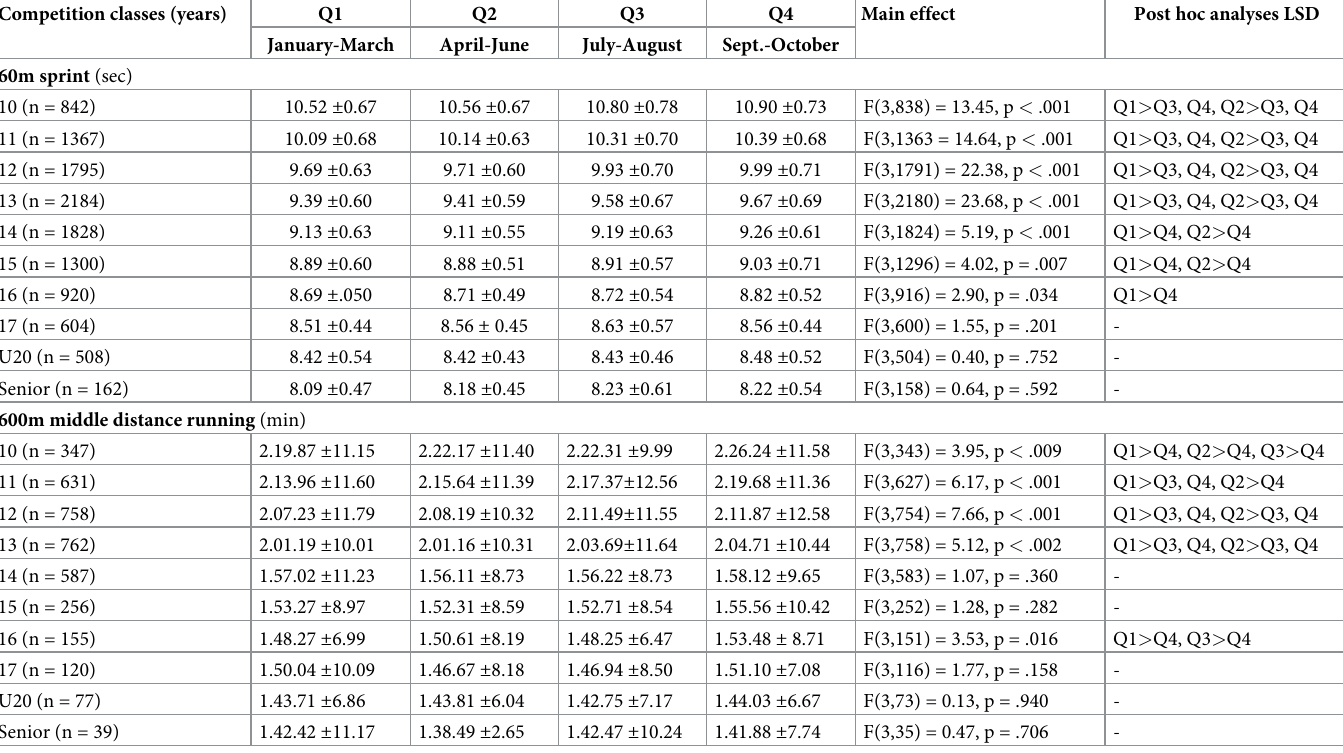
U20: 18–19 years, Senior: 20–34 years. > indicate significant better performance for athletes born in quartiles at the left side of the sign compared to those born in quartiles at the right